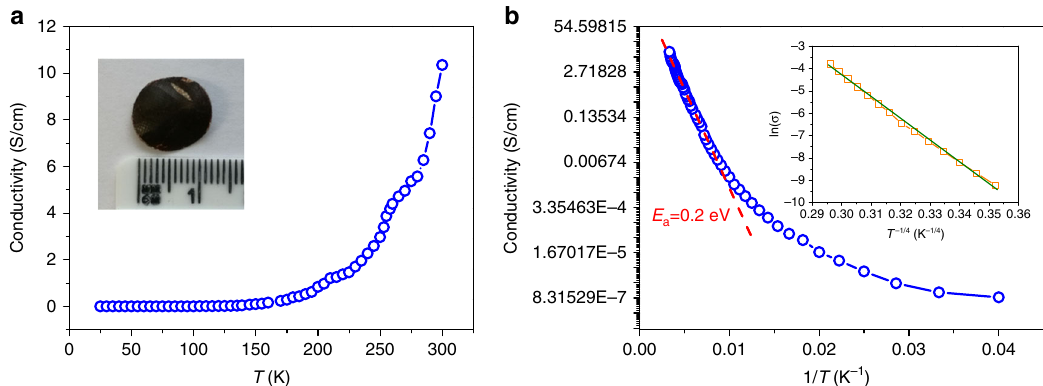
Fig. 4 Electrical conductivity of PTC-Fe 2D MOFs. a Electrical conductivity ( σ ) as a functional of temperature ranging from 30 K to 300 K. b Plot of ln σ versus the reciprocal of the temperature (1/ T ). Inset: Plot of ln ( σ ) versus T − 1/4 over the temperature region 65 – 130